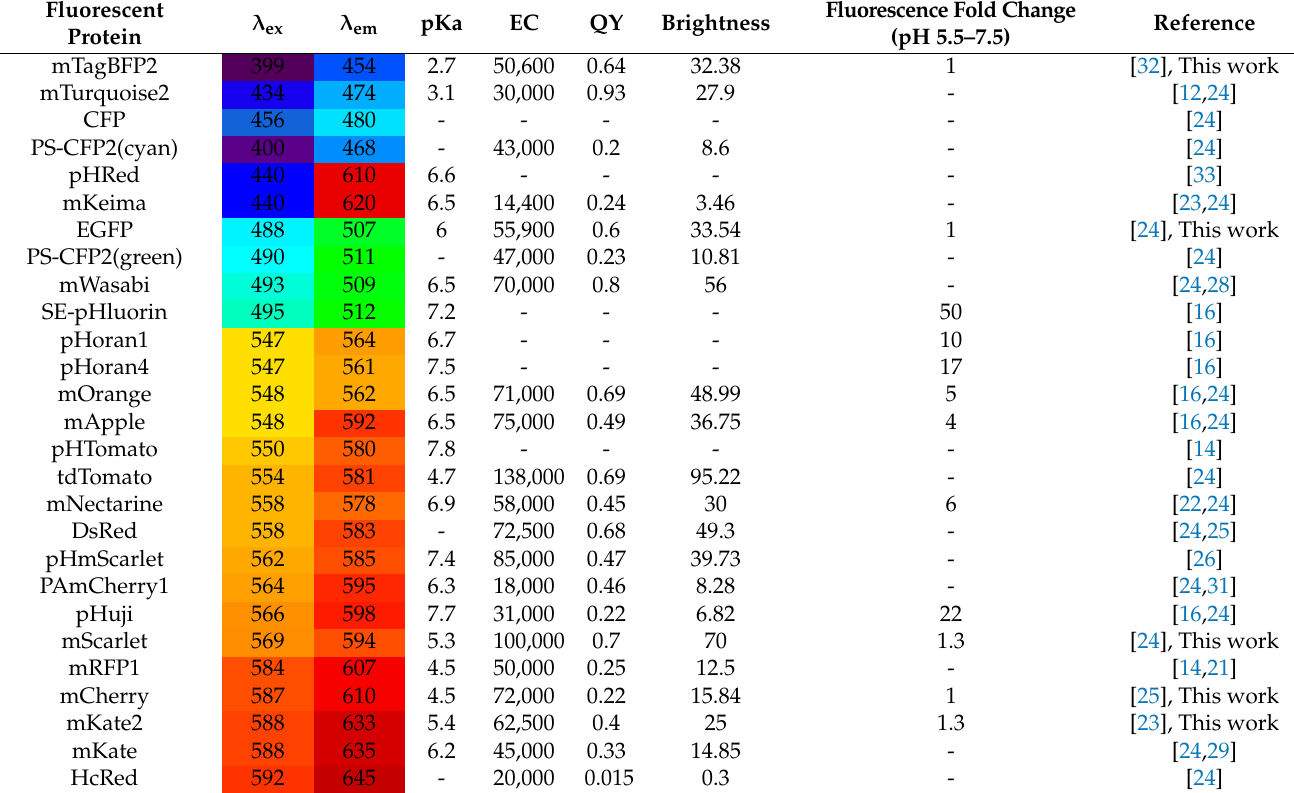
Table 1. Different fluorescent proteins and their physicochemical properties. Different properties of various fluorescent proteins (FPs) are summarized: maximal excitation and emission wavelengths, pKa, extinction coefficient (EC), quantum yield (QY), brightness (a relative brightness, % of enhanced green fluorescent protein (EGFP)), fluorescence fold change between pH 5.5 and